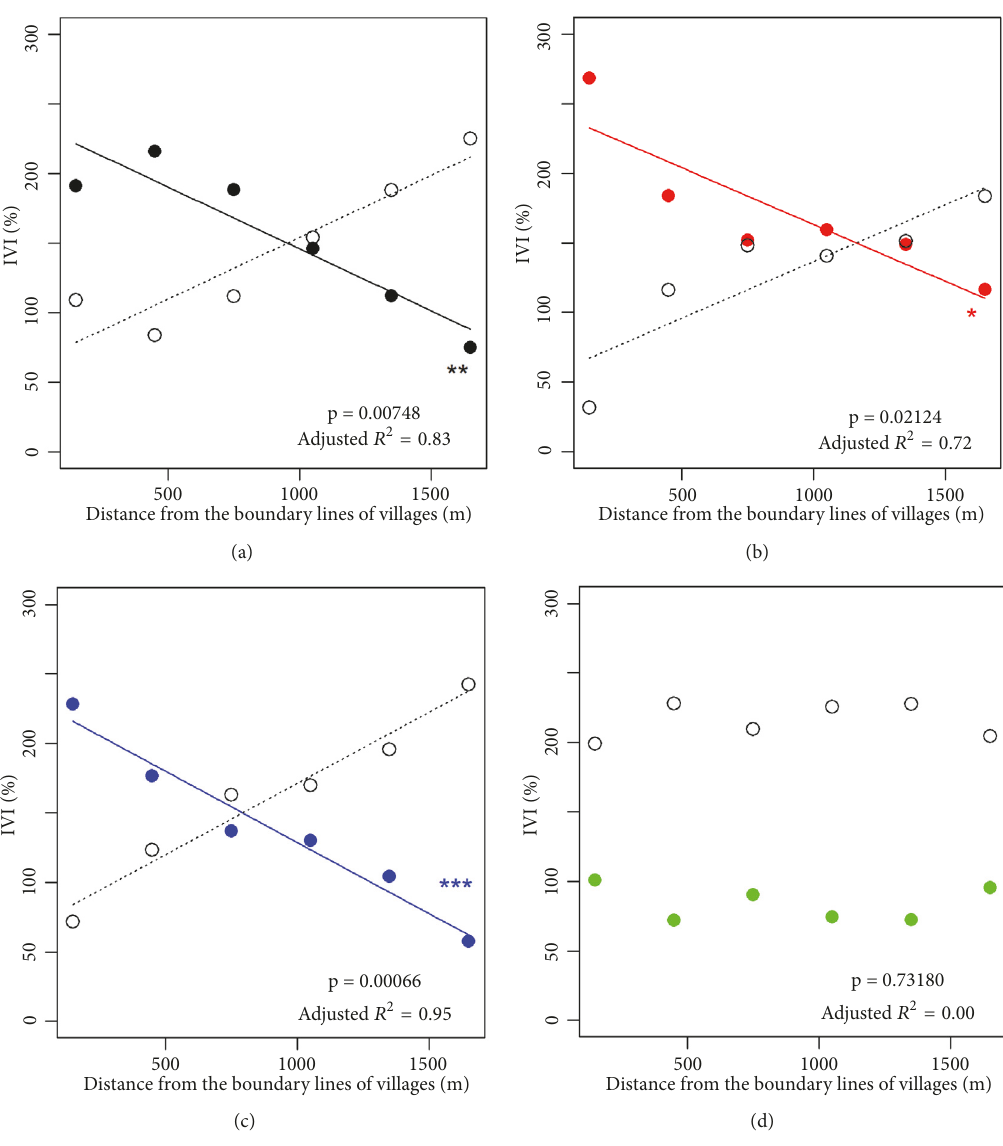
Figure 8: IVI (%) as a function of the distance from the village boundaries. (a) Janajagaran BZCF: significant (p < 0.01), (b) Musharni Mai BZCF: significant (p < 0.05), (c) Radha Krishna BZCF: significant (p < 0.001), and (d) Parsa Wildlife Reserve: nonsignificant (p > 0.05). The solid lines in the figure indicate IVI (%) of S. robusta and the dotted lines indicate total IVI (%) of other species except for S. robusta .